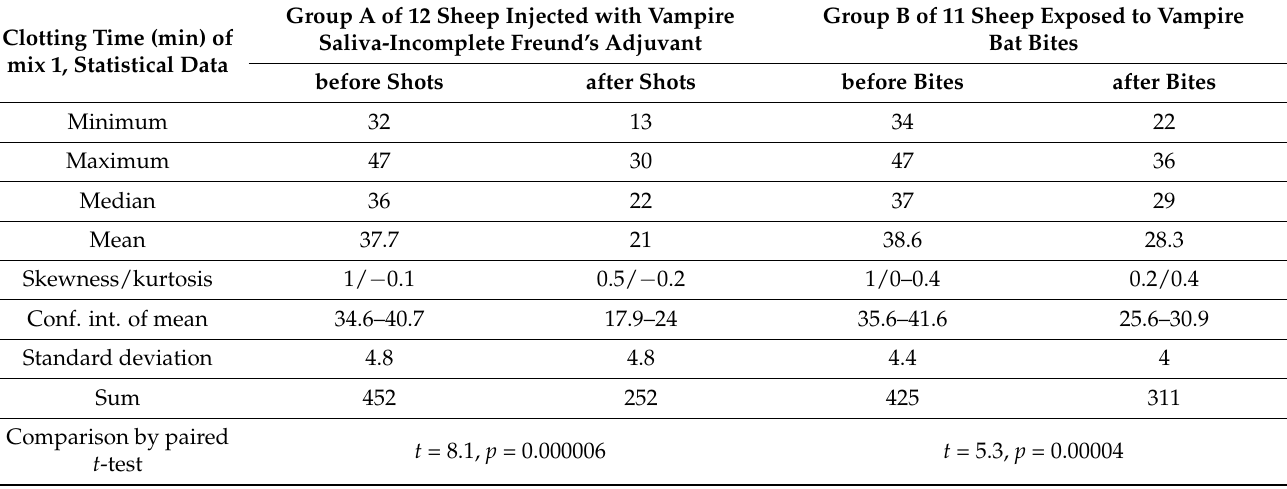
Table 2. Observation of the clotting time (min) of * mix 1 to evaluate resistance against ** VSA in sheep of groups A and B after they were administered vampire bat saliva–incomplete Freund’s adjuvant or exposed to vampire bat bites, respectively. Clotting Time (min) of mix 1, Statistical